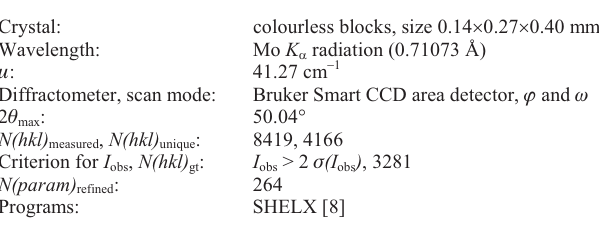
Table 1. Data collection and